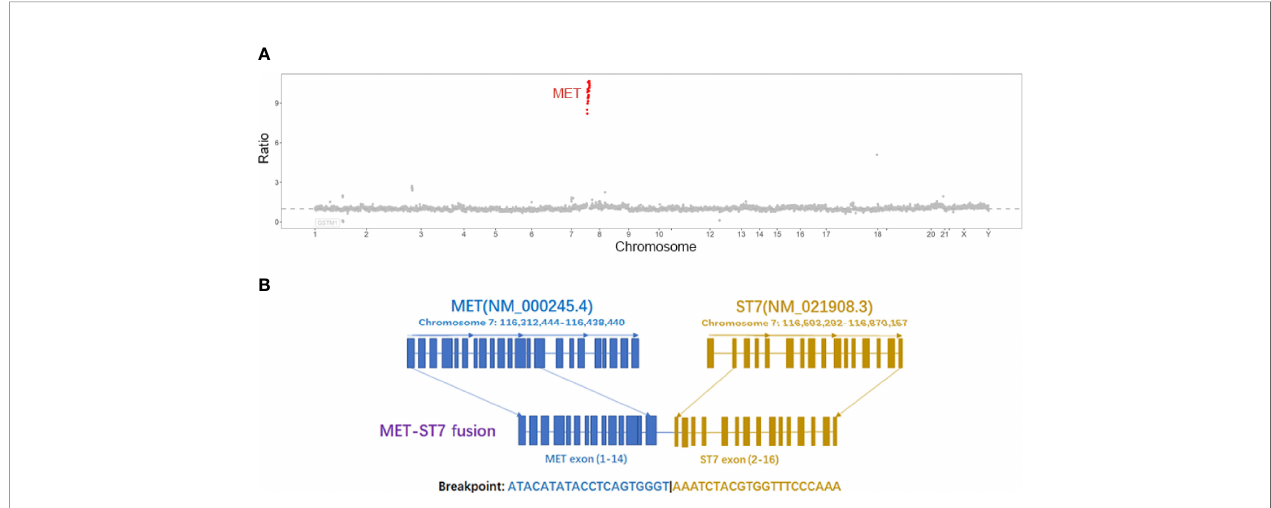
FIGURE 2 | (A) The copy number ratio of MET to centromere of chromosome 7 in tissues, each red point represents an exon of MET ; (B) MET-ST7 fusion